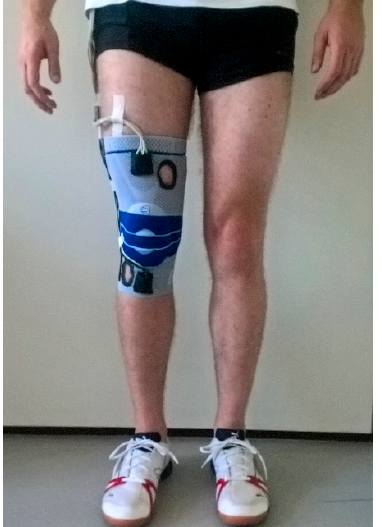
Figure 1. Placement of inertial measurement units (IMUs) used in the study. The IMUs were positioned in the two black patch pockets at the upper and lower frontal end of the sleeve.